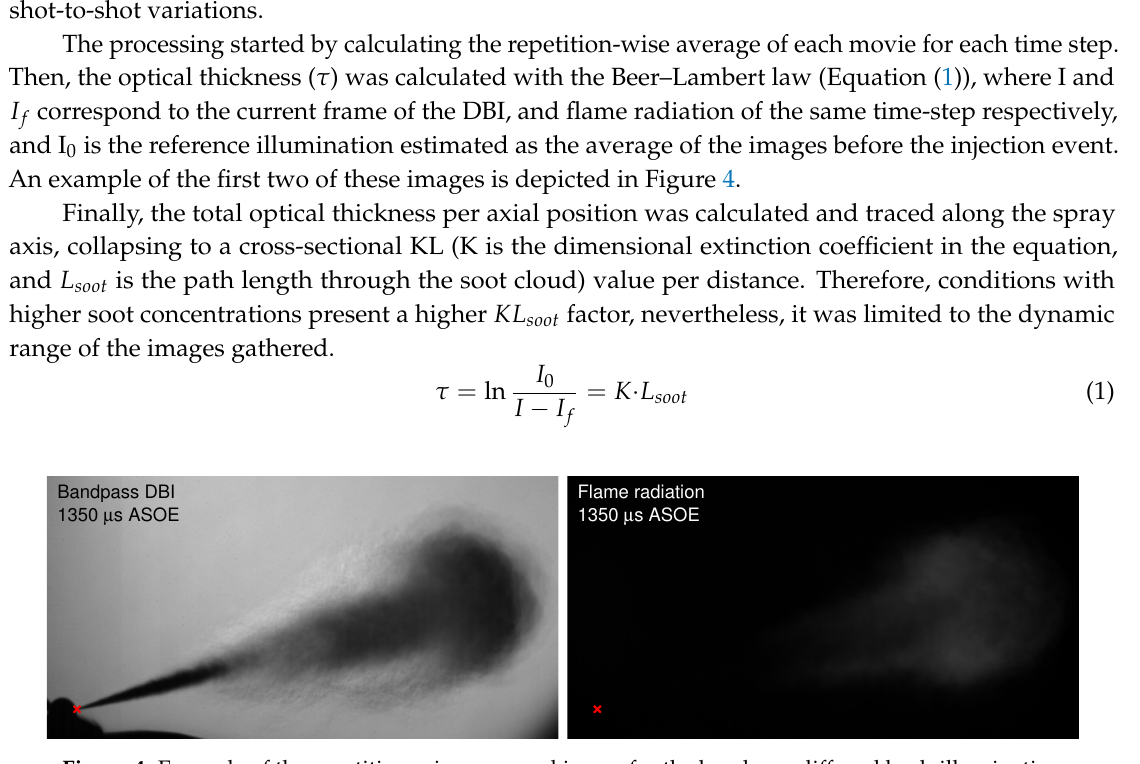
Figure 4. Example of the repetition-wise averaged image for the bandpass diffused back-illumination (DBI) (left) and flame radiation (right) setups. The frames shown are for a single injection event, a rail pressure of 100 MPa, a chamber density of 22.8 kg · m − 3 , and temperature of 900